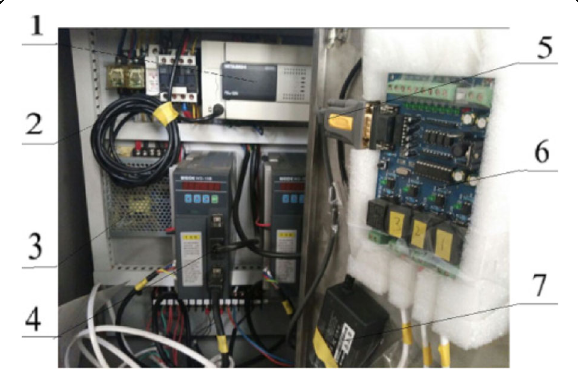
Fig. 2 System control cabinet. 1 PLC controller, 2 relay, 3 PLC power supply module, 4 Servo motor driver, 5 signal cable, 6 MCU, 7 MCU power